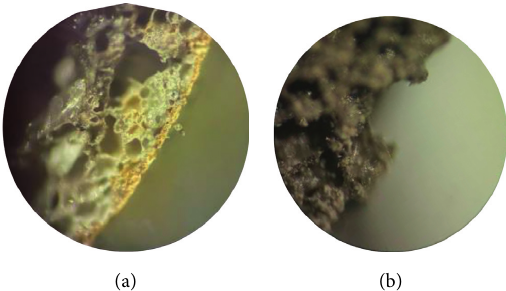
Figure 3: Surface of (a) original (smooth surface) and (b) treated (rough surface) lightweight aggregate used (scale: 5mm diameter).